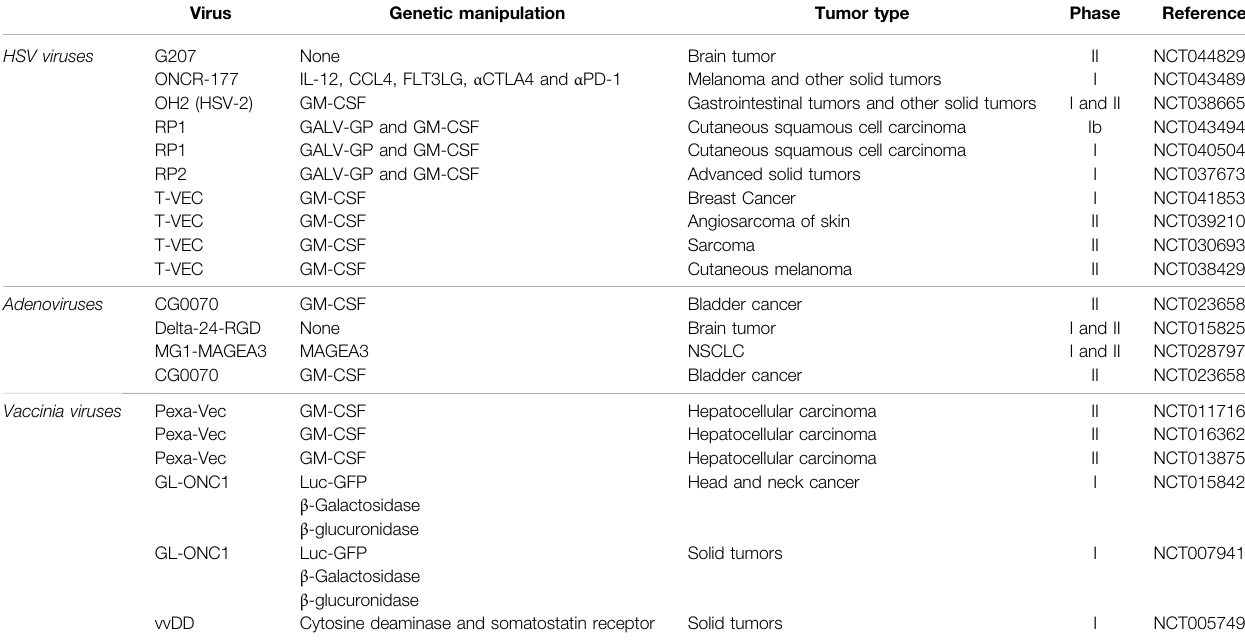
TABLE 1 | Completed clinical trials of oncolytic